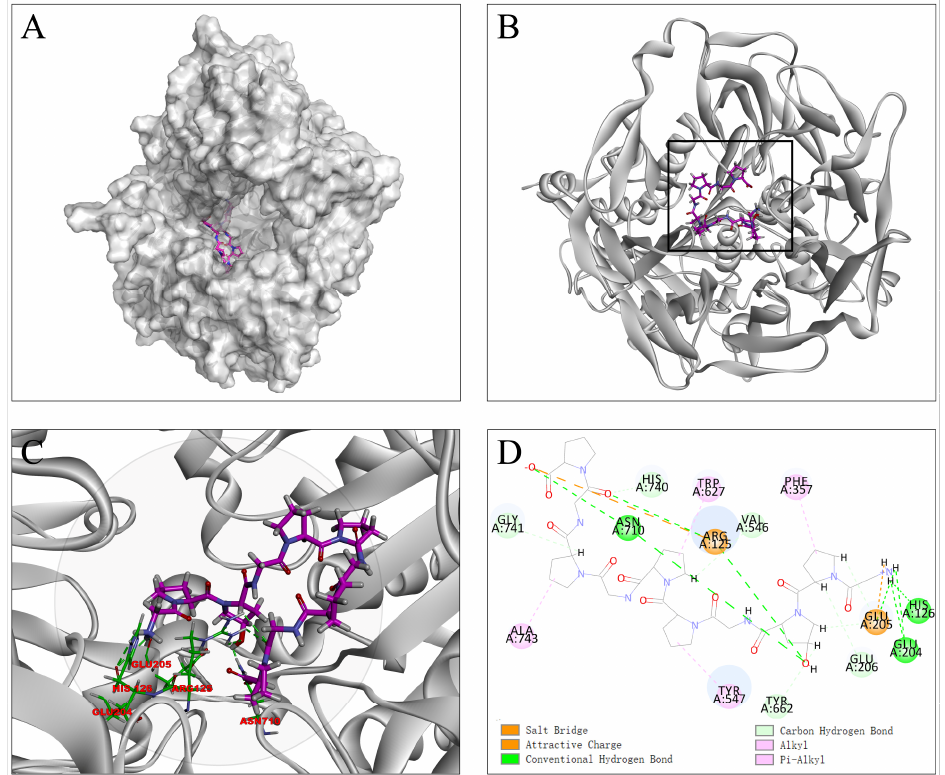
Figure 2. Molecular docking between GPXGPPGPGP and DPP-IV. ( A ) Predicted binding orientation of GPXGPPGPGP (shown in purple) at the ligand-binding site of DPP-IV (shown in grey). ( B ) A 3D view of the best conformation of the GPXGPPGPGP docking with DPP-IV. ( C ) The specific residues of the calculated binding site in DPP-IV. The hydrogen bonds are indicated by green dotted lines.